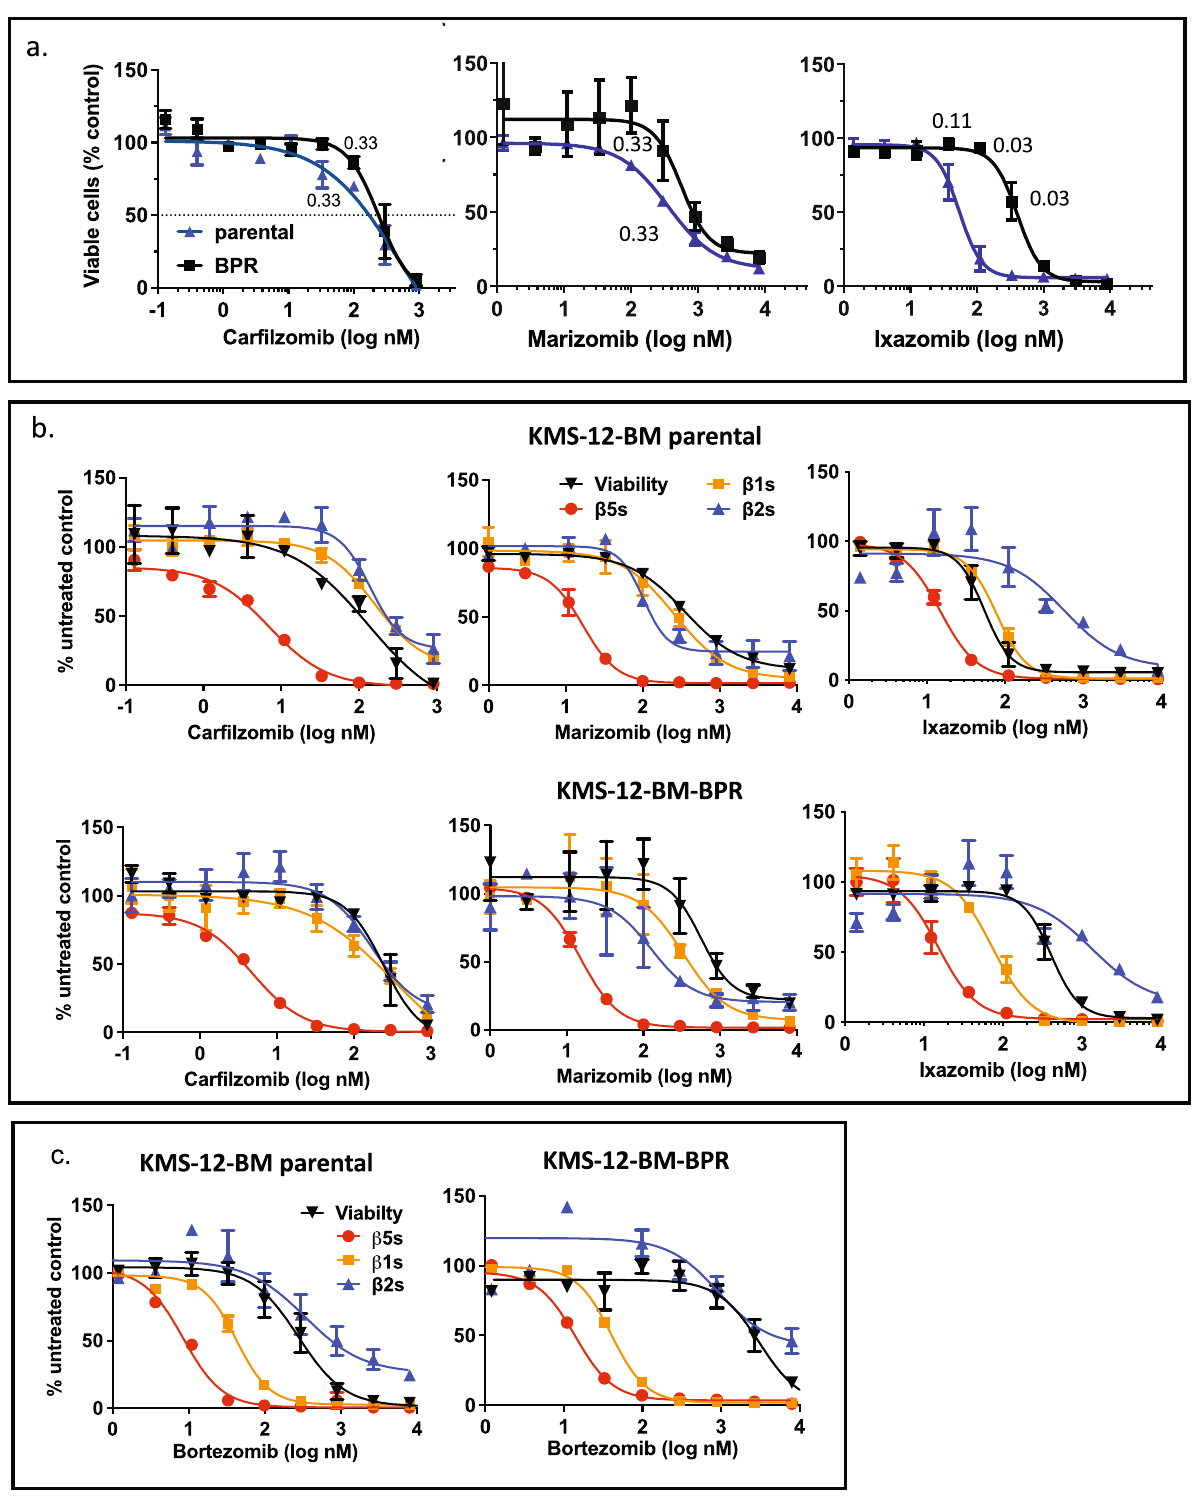
Figure 2. Cfz and Mzb but no Ixz overcome resistance to Btz. ( a ) Cells were treated with Cfz (n = 2) and Mzb (n = 2) for 1 h, and Alamar Blue assay was performed 48 h later. Cells were treated with Ixz continuously (n = 4) because Ixz is reversible and persists in patient blood much longer than other inhibitors 44,45 . The numbers on the graphs are p-values. Continuous treatment with Cfz also reversed resistance (Fig. S1d). ( b , c ) Inhibition of each active site was measured with Proteasome-Glo immediately after 1 h treatment and overlayed on viability data from ( a ), ( b ) or Fig. 1b ( c ); n =